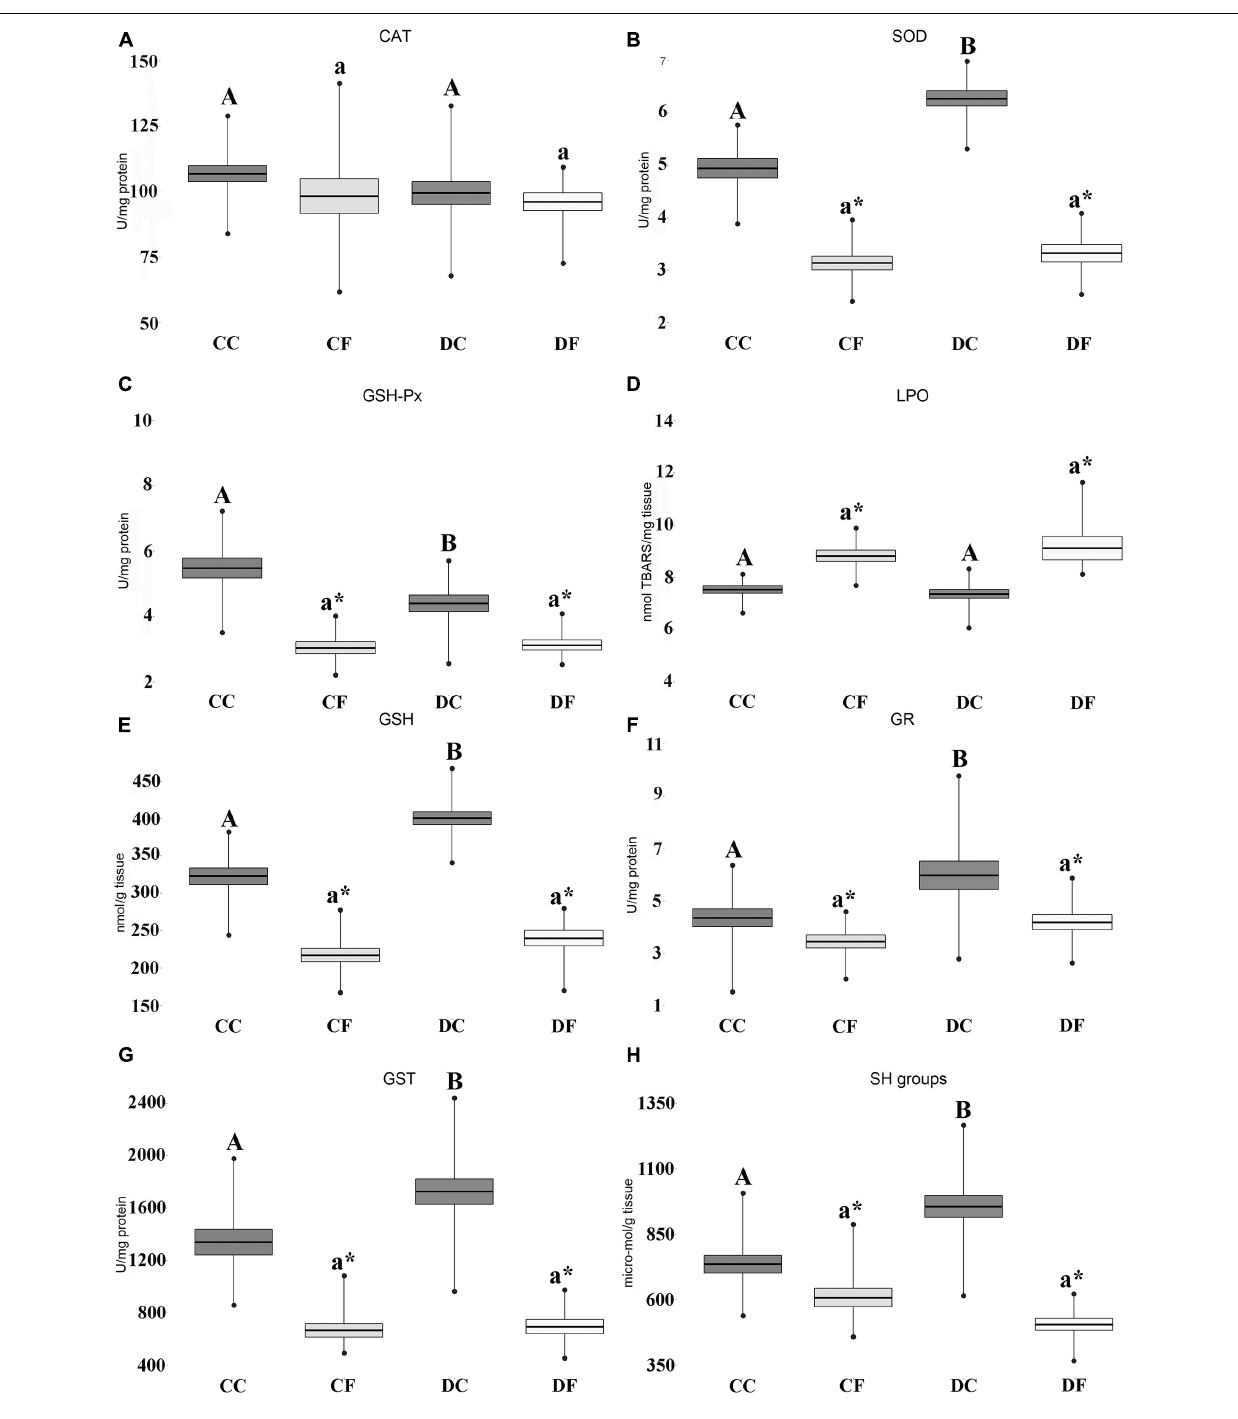
Frontiers in Physiology |